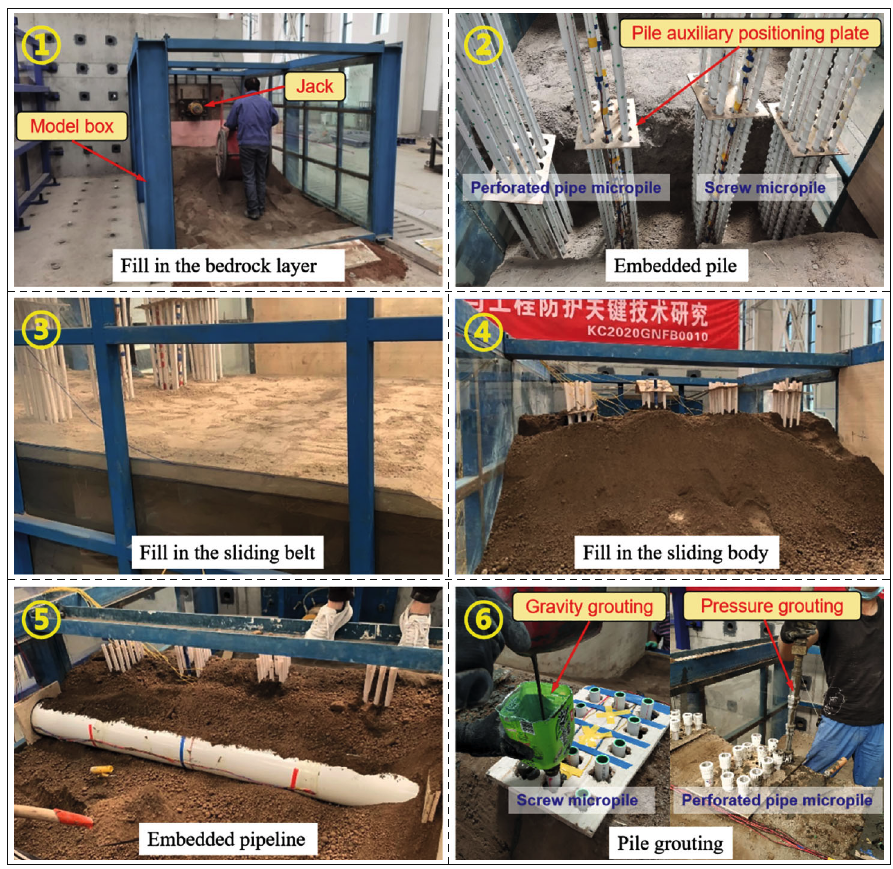
Figure 6: Model fi lling